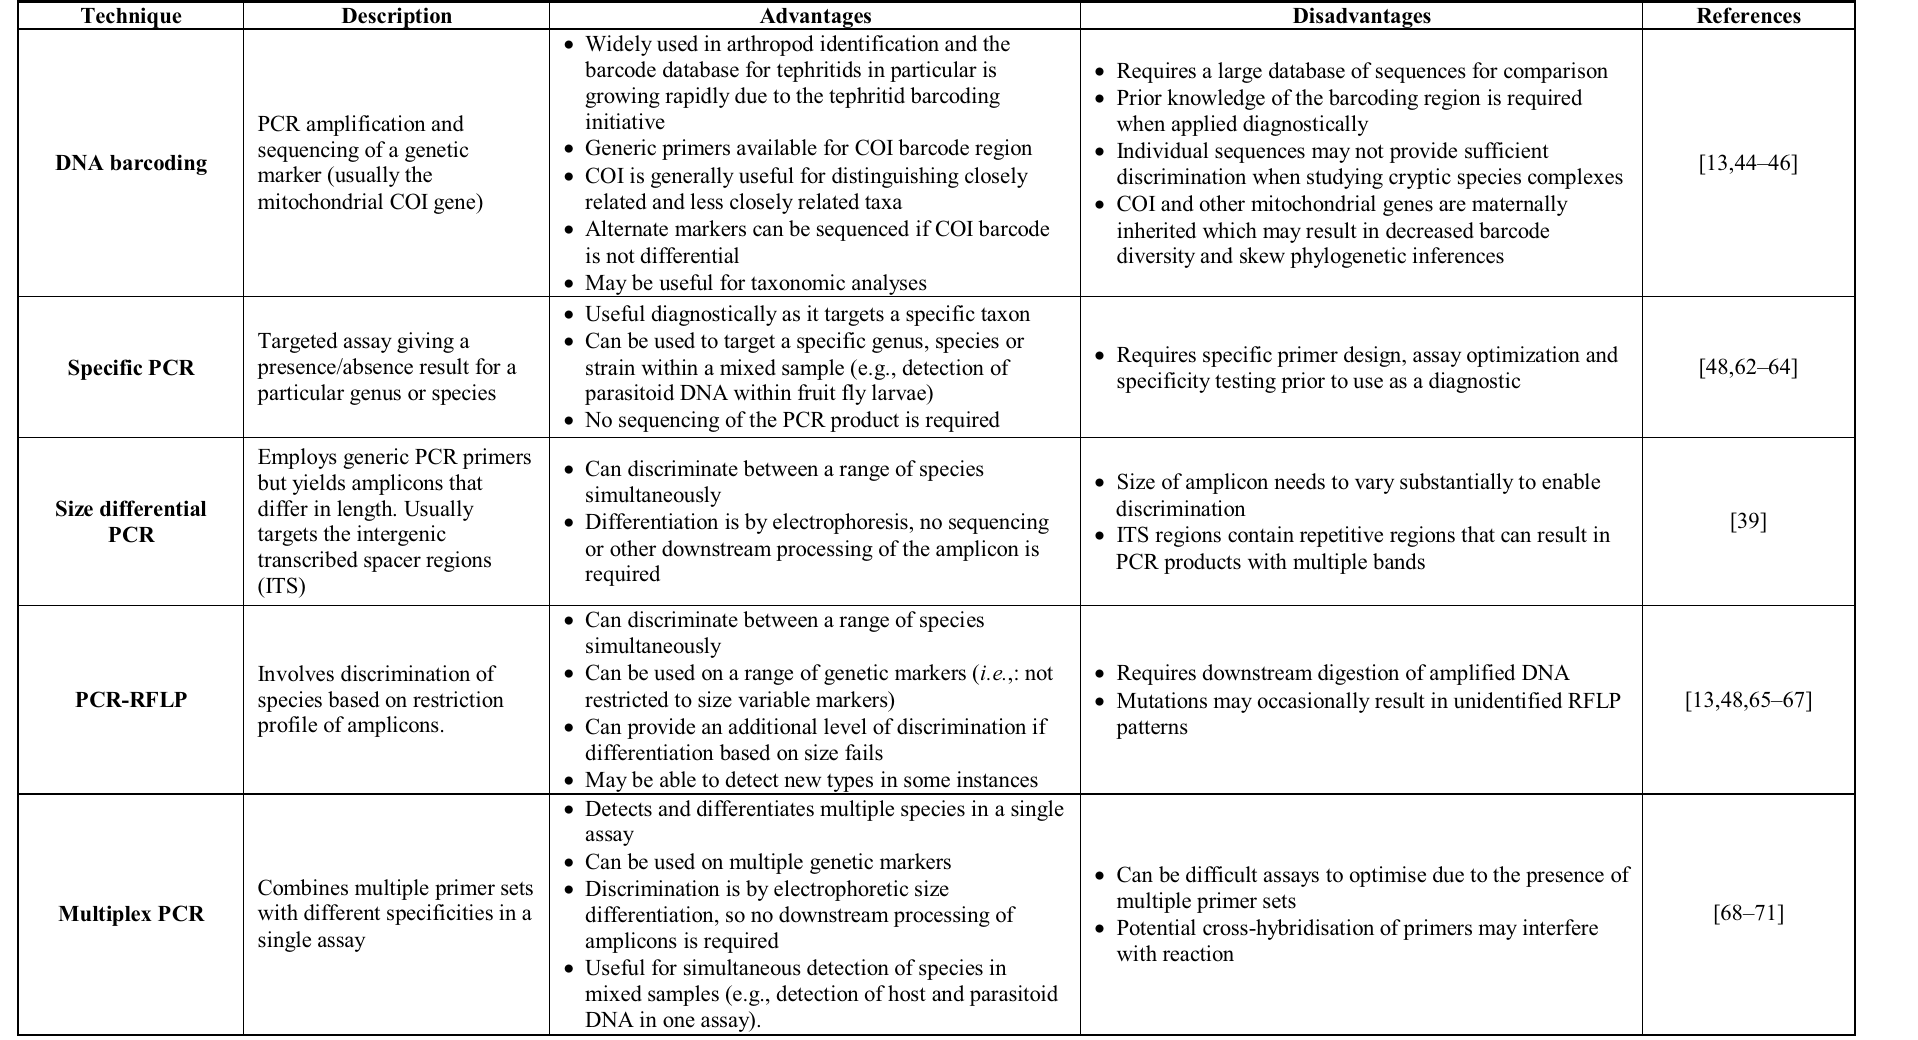
Table 1. Comparison of molecular techniques for tephritid and parasitoid detection and